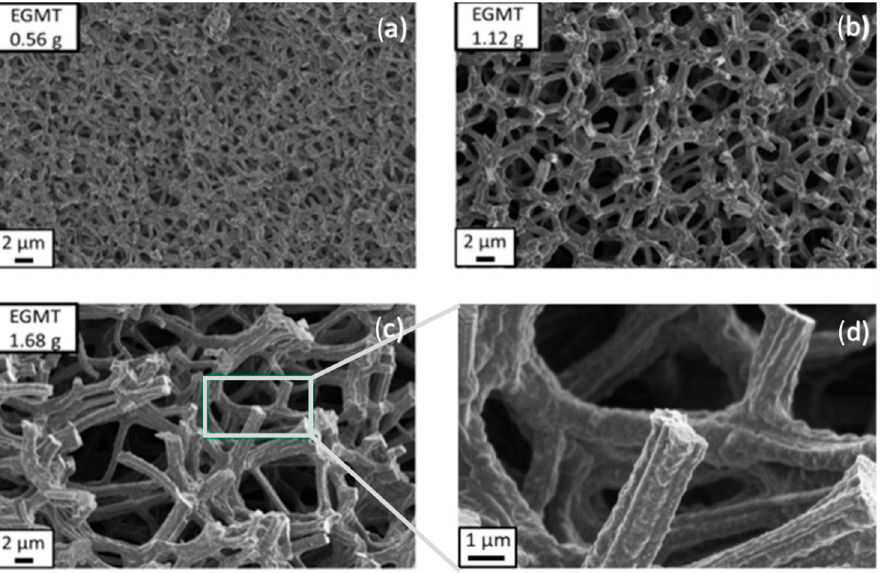
Figure 18. SEM photomicrographs of C/TiO 2 with increasing amounts of TiO 2 (Ti precursor EGMT): ( a ) 0.56 g; ( b ) 1.12 g; ( c ) 1.68 g; ( d ) magnification of ( c ). Reprinted with permission from J. Schoiber,